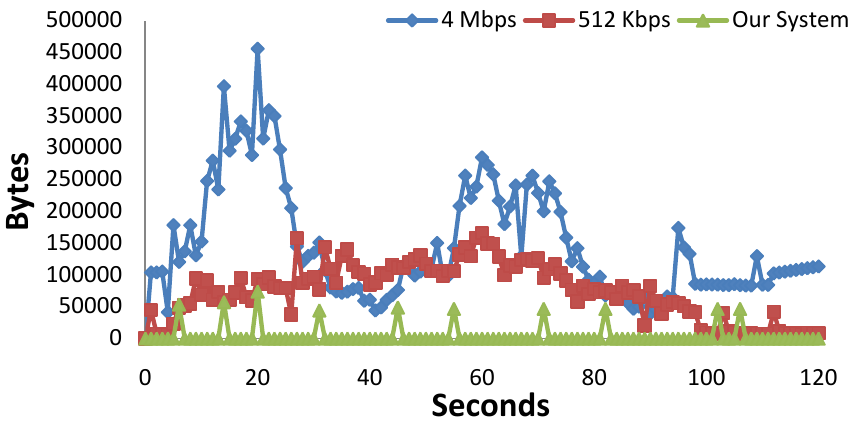
Figure 18. Bytes comparison when there is 4 Mbps video stream, 512 kbps video stream and our system.